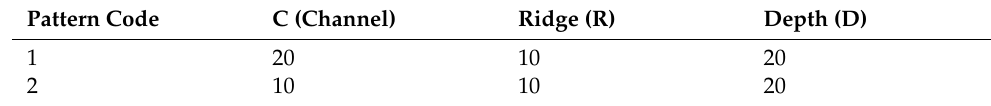
Table 1. Pattern dimensions (in µ m) of silicon wafers.